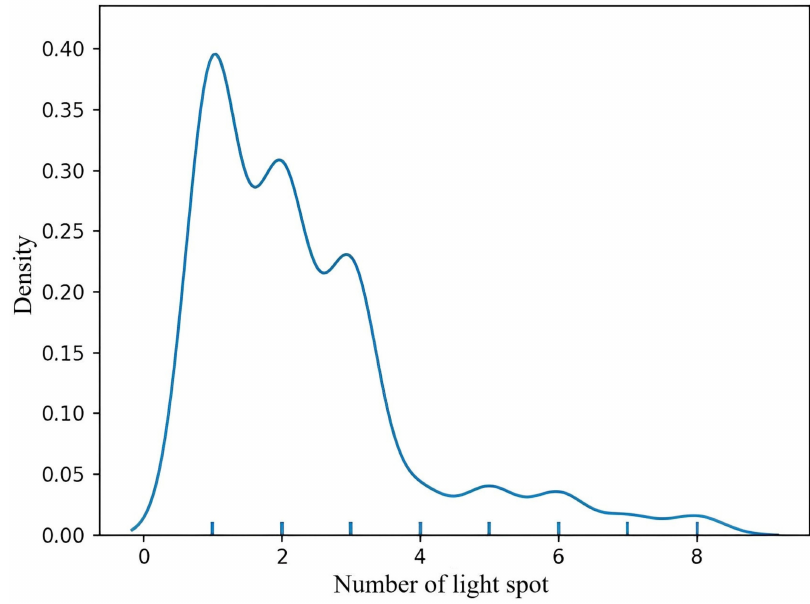
Figure 6. Density